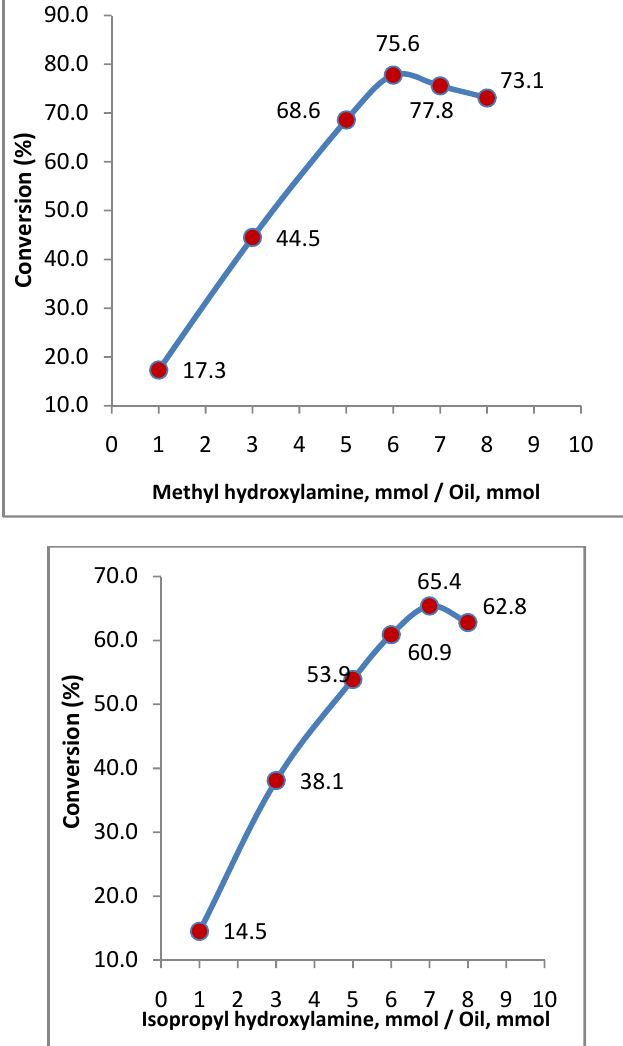
Figure 1. Effect of the mol ratio of N -MHA to oil on methyl hydroxylaminolysis, isopropyl hydroxylaminolysis and benzyl hydroxylaminolysis of palm kernel oil. Reaction conditions: Reaction time = 72 h, temperature = 39 °C, shaking rate = 120 rpm, Lipozyme O = 14 mL, palm kernel oil = 710 mg (1 TL IM = 80 mg, hexane = 10 mL, H 2